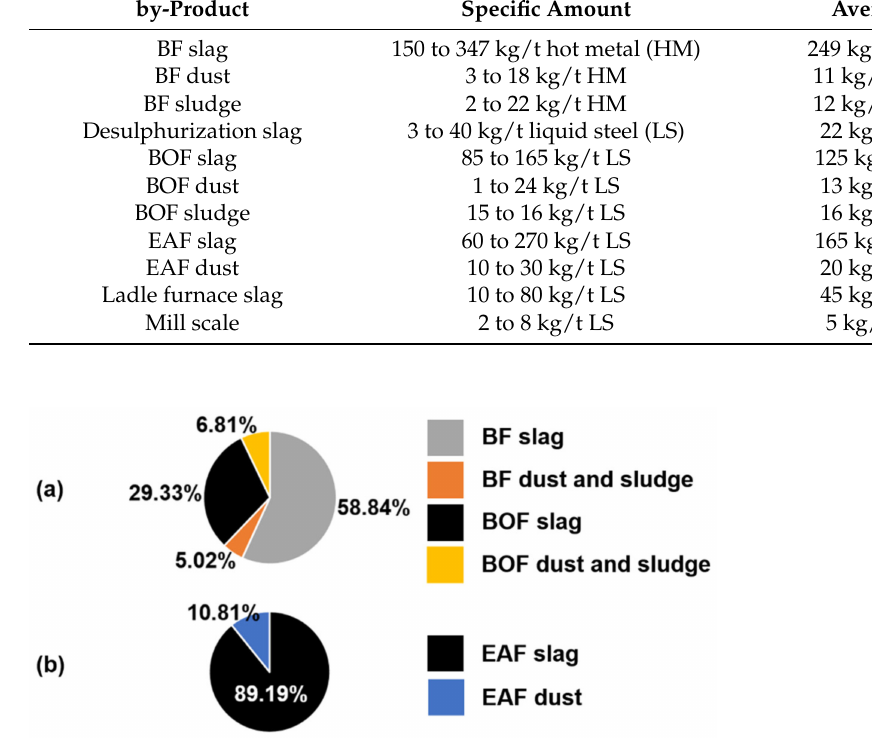
Figure 2. Percentage of generated slags, dusts, and sludges from hot metal and crude steel production via the BF-BOF route ( a ) and the EAF route ( b